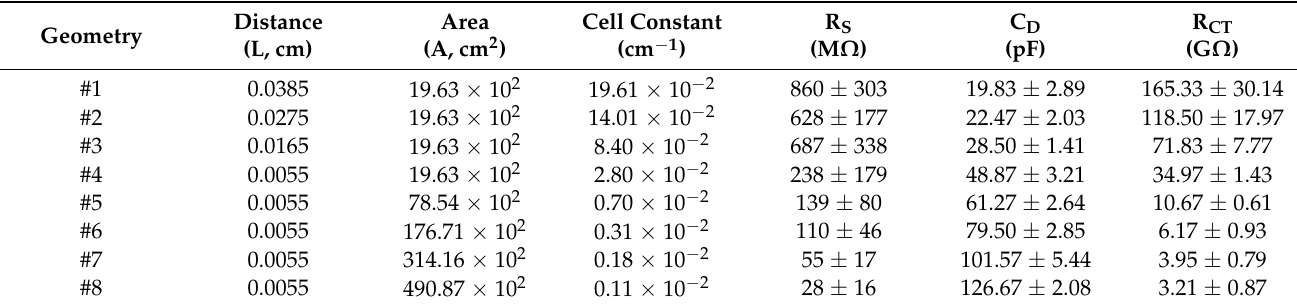
Figure 2. Nyquist diagrams of fresh palm oil with a cell constant of 19.61 × 10 − 2 ( (cid:4) ), 14.01 × 10 − 2 ( (cid:3) ), 8.40 × 10 − 2 ( (cid:78) ), 2.80 × 10 − 2 ( ∆ ), 0.70 × 10 − 2 ( • ), 0.31 × 10 − 2 ( and 0.11 × 10 − 2 ( ♦ ) cm − 1 . Applied potential: 0 V; amplitude: 100 mV; frequency range: 1–0.01 Hz; temperature: 30 ◦ C. The inset shows a closer view of the Nyquist curves with lower cell constants, as well as the equivalent circuit model. Table 1. Impedance analysis of fresh palm oil with various electrochemical cell geometries based on the simplified Randles equivalent circuit model without the Warburg diffusion